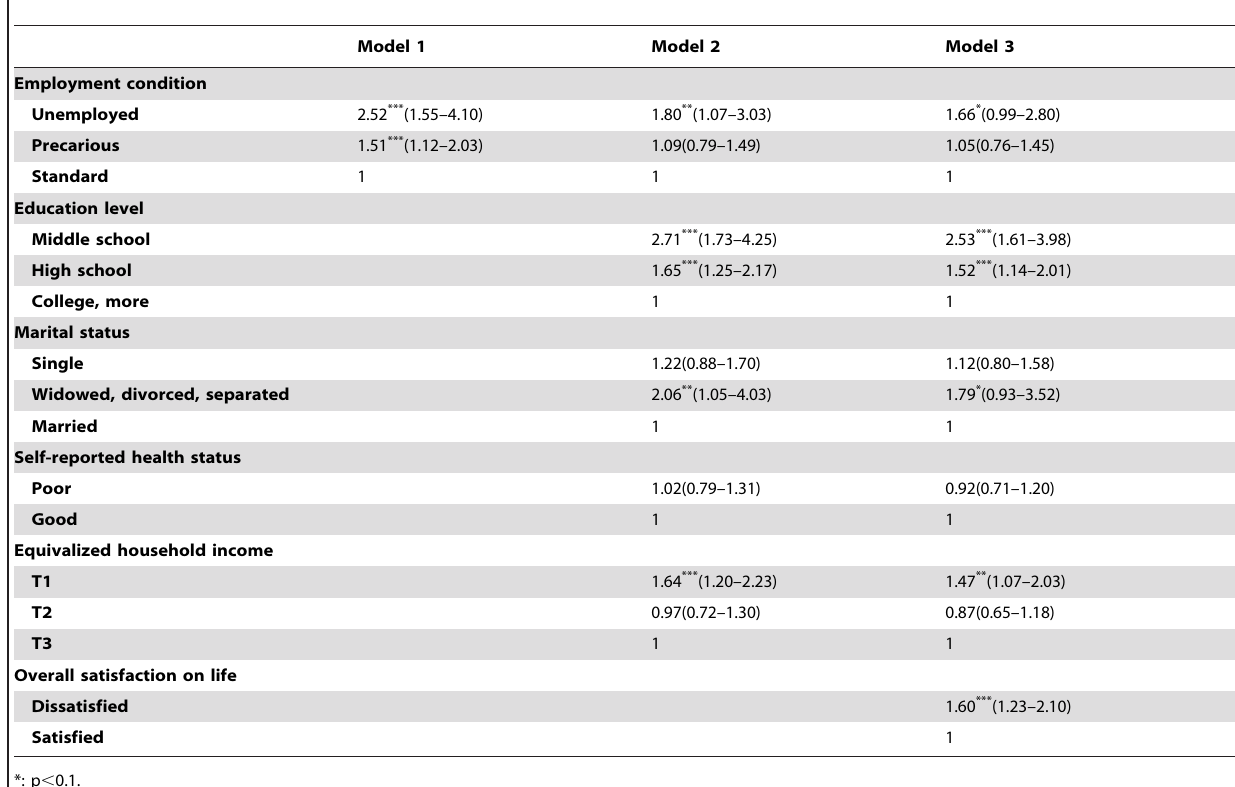
Table 5. Adjusted odds ratios a (95% confidence interval) of re-initiating smoking according to employment status among 2005 or 2006 non-smokers (N